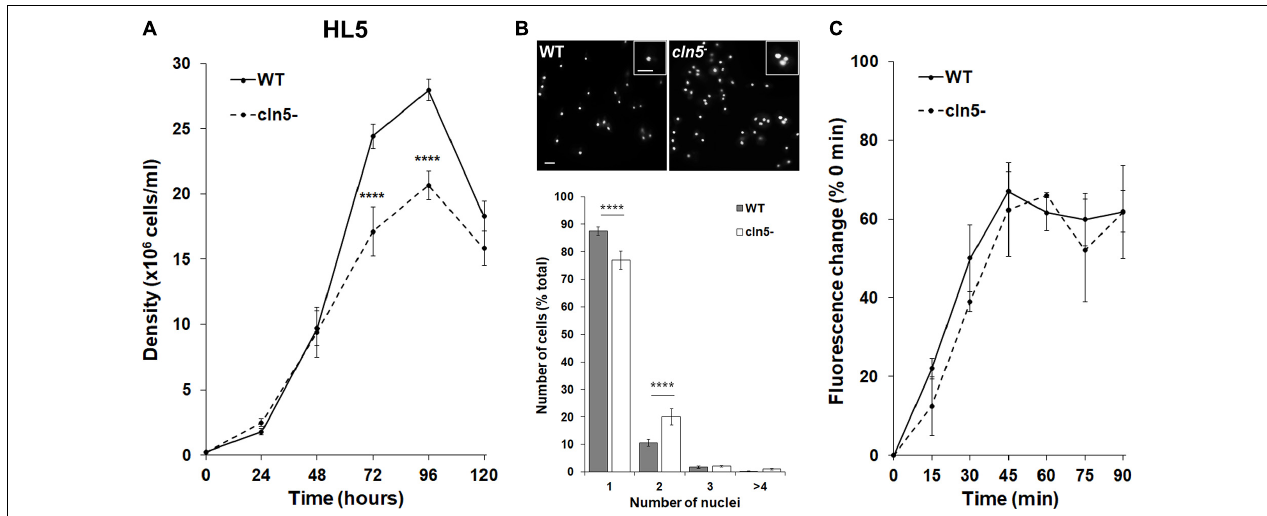
FIGURE 1 | Effect of cln5 -deficiency on cell proliferation, cytokinesis, and pinocytosis in HL5. (A) WT and cln5 − cells were placed in HL5 at 1.0 × 10 5 cells/ml. Cell densities were measured every 24 h for 120 h. Data presented as mean density ± SEM ( n = 11). Statistical significance was assessed using two-way ANOVA followed by Bonferroni’s multiple comparisons test. **** p -value < 0.0001 at the indicated time points vs. WT. (B) Growth-phase WT and cln5 − cells were fixed on coverslips and stained with DAPI to reveal nuclei. The percentage of cells in the population containing 1, 2, 3, or ≥ 4 nuclei was measured. Data presented as mean number of cells (% total) ± SEM ( n = 6). Statistical significance was determined using the Student’s t -test. **** p -value < 0.0001 vs. WT. Scale bar = 10 µ m. (C) WT and cln5 − cells (5.0 × 10 6 cells/ml) were incubated in HL5 containing FITC-dextran (400 µ g/ml). Starting at 0 min, and every 15 min thereafter, cells were collected, washed with ice-cold Sorenson’s buffer, and lysed. The fluorescence of the lysates was then measured. Data presented as mean fluorescence change (% 0 min) ± SEM ( n = 3).